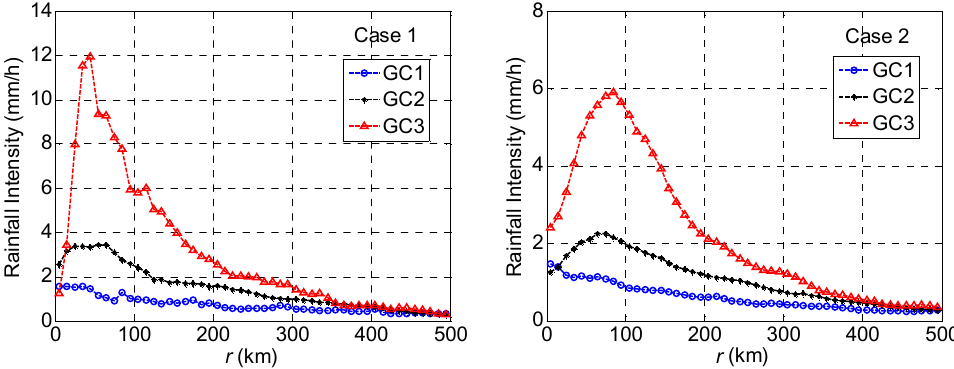
Figure 2. Average rainfall intensity and predicted rainfall intensity.